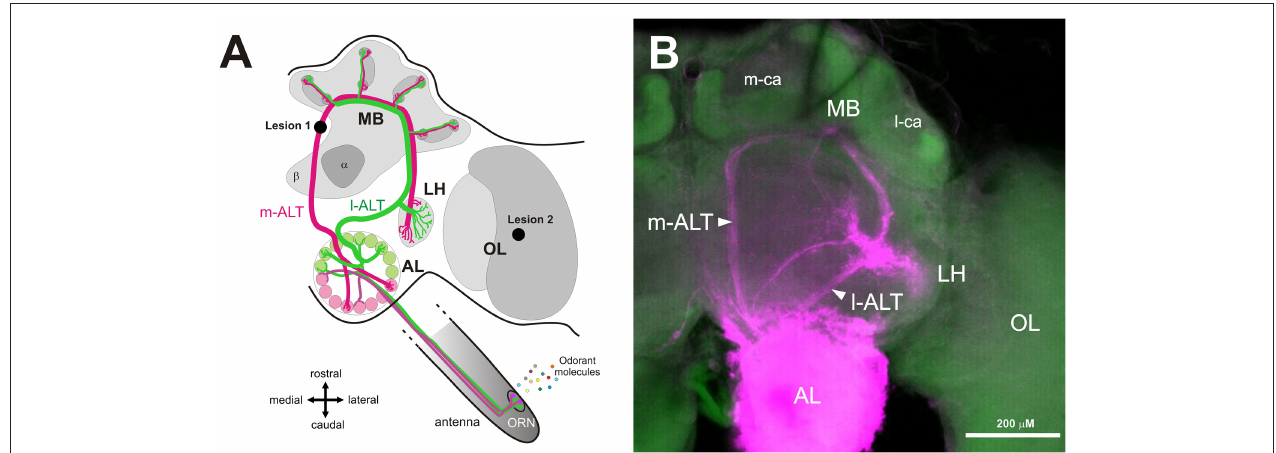
FIGURE 1 | Dual olfactory pathway of the honey bee brain. (A) Schematic overview of the dual olfactory pathway of the honey bee brain (adapted from Carcaud et al., 2012, 2015). Odorant molecules are detected by olfactory receptor neurons (ORN) on the antenna which project to the antennal lobe (AL). Then, projection neurons (PN) convey information to the mushroom bodies (MB) and the lateral horn (LH) via two main tracts, the medial antennal lobe tract (m-ALT, magenta) and the lateral antennal lobe tract (l-ALT, green). Lesion site of the m-ALT and of the optic lobe (OL) are indicated (lesion 1 and lesion 2 respectively). (B) Mass staining in the AL, showing the course of l-ALT and m-ALT PNs from the AL to LH and the MB calyces. Abbreviations: m-ca, median calyx; l-ca, lateral